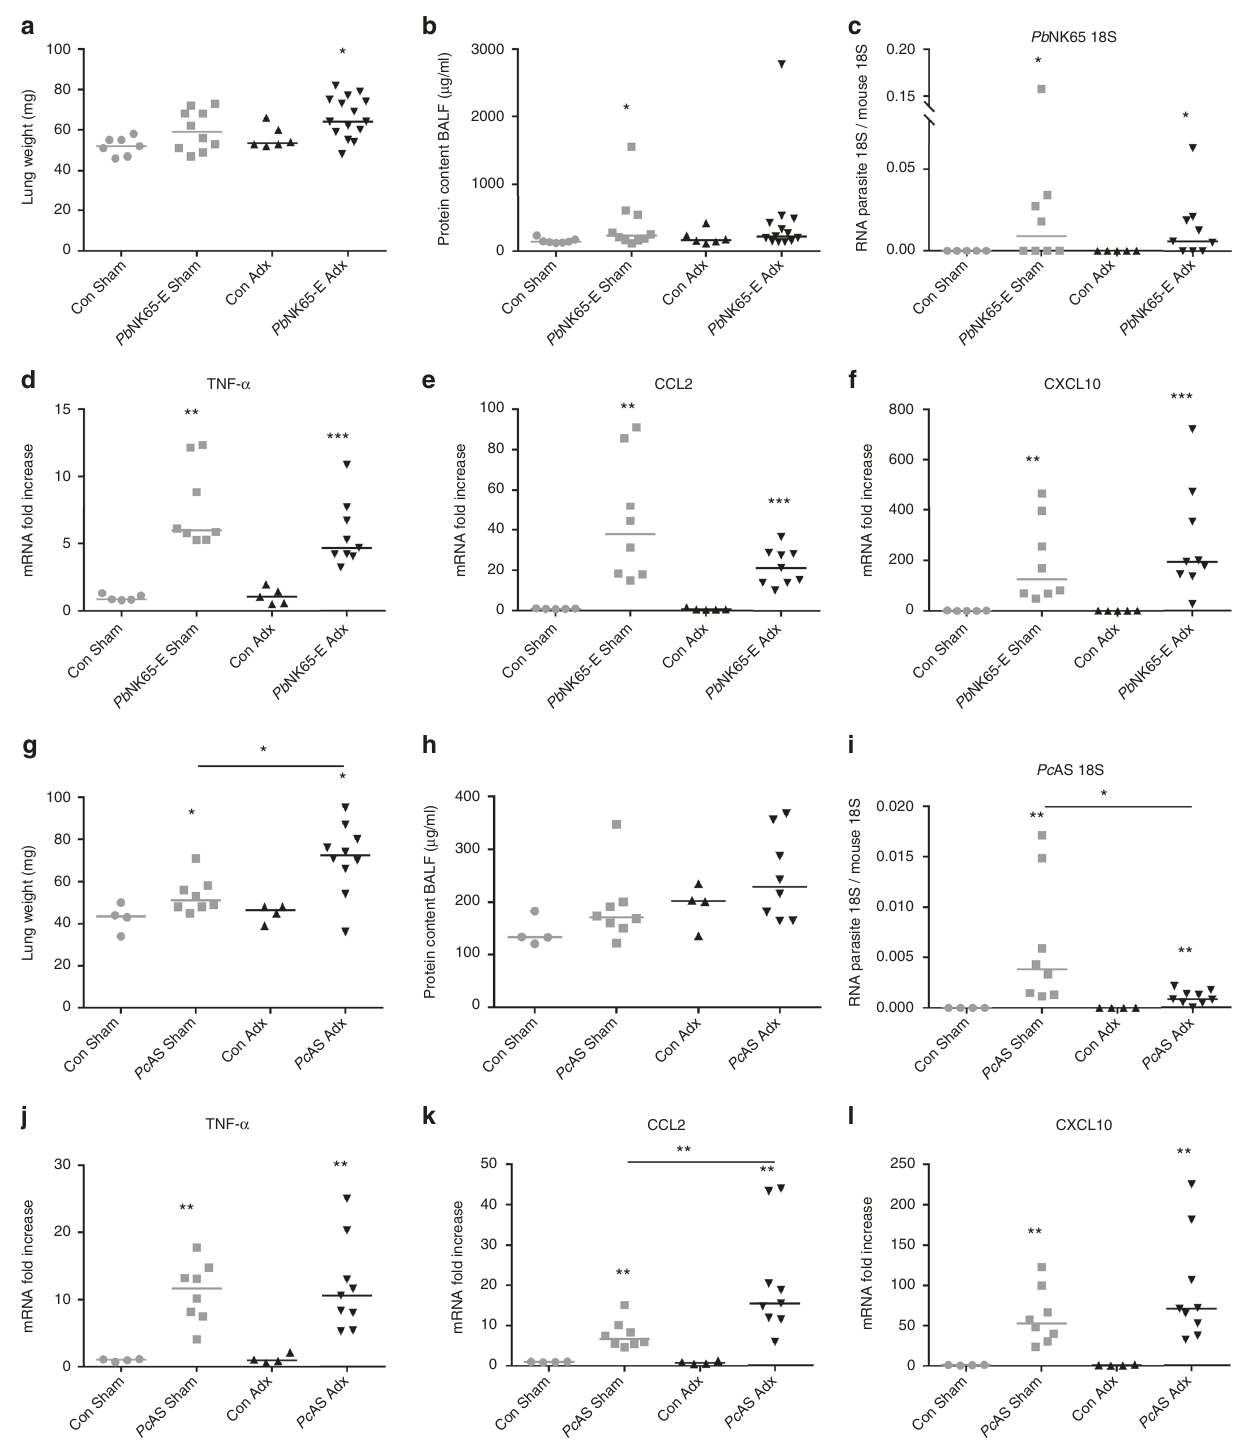
Fig. 2 Adrenalectomy has no major effect on malaria-induced pathology and in fl ammation in the lungs. Sham and Adx BALB/c mice ( a – f ) or C57BL/6 mice ( g – l ) were infected with Pb NK65-E or Pc AS, respectively. Infected mice were euthanized and dissected at 6 to 7 days p.i. ( Pb NK65-E) or 8 to 9 days p.i. ( Pc AS). a , g Weight of left lungs. b , h Bronchoalveolar lavage fl uid (BALF) samples were collected and the protein contents of centrifuged supernatants was determined. ( c – f and i – l ) Lungs were homogenized and speci fi c mRNA levels were measured by qRT-PCR. Each symbol represents data from an individual mouse. Horizontal lines in between data points represent group medians and analysis was by Mann-Whitney U -test. Horizontal lines with asterisks on top indicate the levels of statistical signi fi cance between the indicated groups. Asterisks above individual data sets indicate the levels of statistical signi fi cance compared to the uninfected control group. Data from two separate experiments. * p < 0.05, ** p < 0.01, *** p <